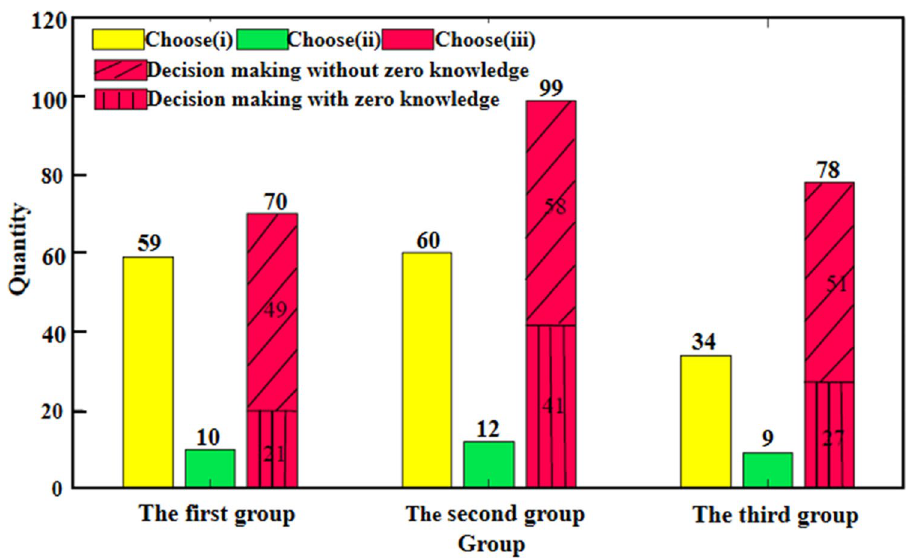
Figure 2. Statistics of the number of decision-makers in Questionnaire